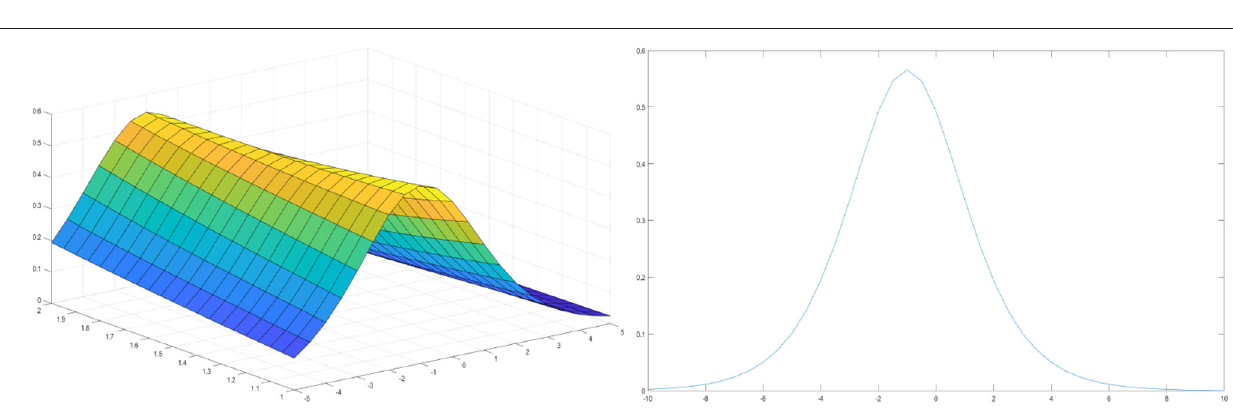
1, α 0.5, p 1, and γ ( t ) = − = =